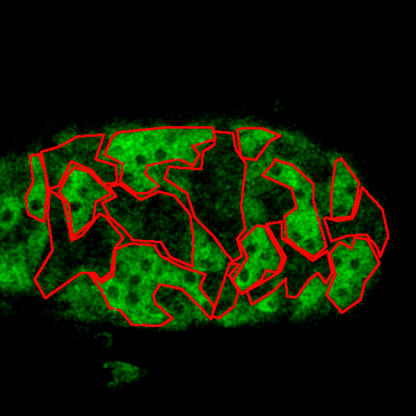
GFP fluorescence within an intact islet marks β-cells that do not have active potassium channels. Regions are outlined that contain cells with either normal or inactive channel activity